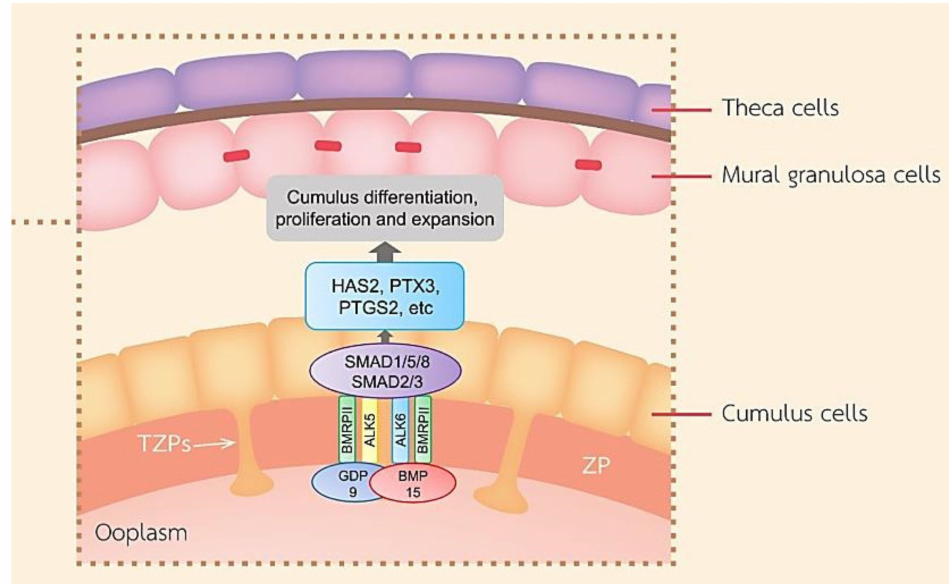
Figure 3. A schematic diagram exhibiting roles of the main TGF- β superfamily member proteins in regulating ovarian function. BMP-15 and GDF-9 promote cumulus marker transcripts. GDF-9 and BMP-15 are important for the function of GCs, CC differentiation and proliferation, COC expansion, and hyaluronan production leading to